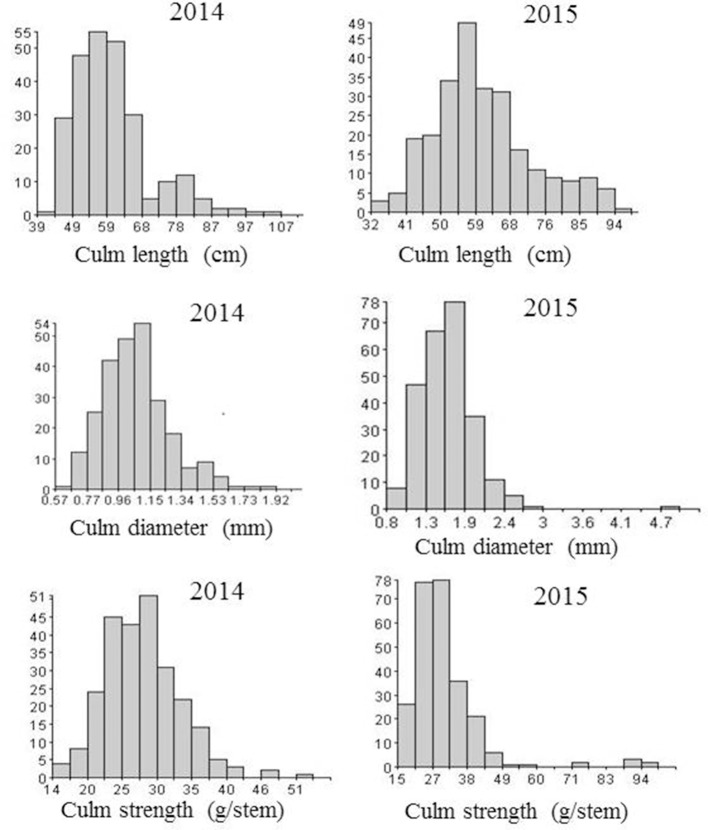
Frequency distribution of lodging-related traits in year 2014 and 2015.